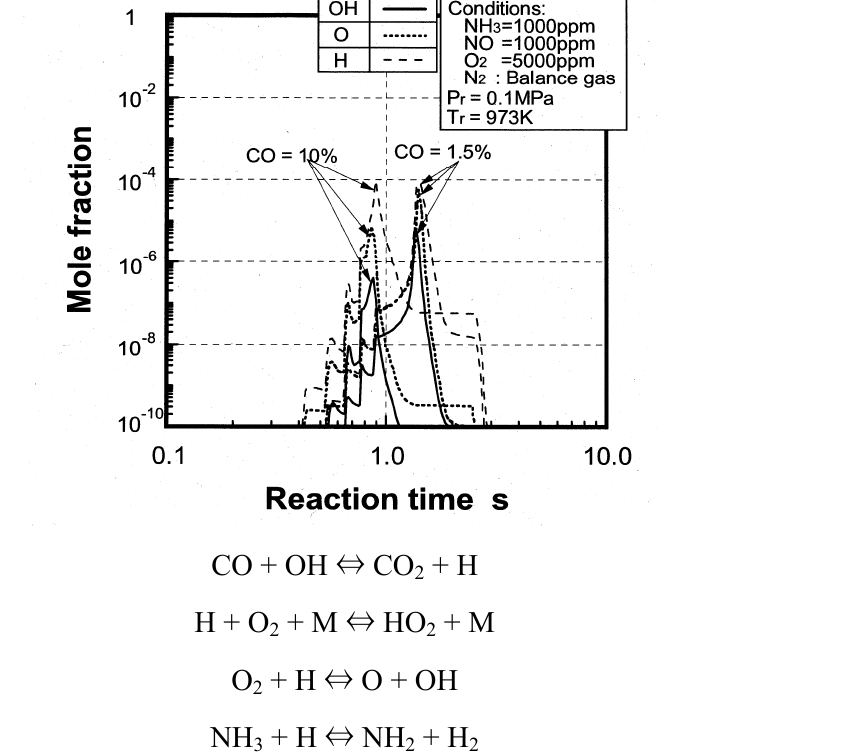
Figure 36. Mole fraction-time profiles of OH, O, H radicals, comparing CO = 0%, 1.5% -NO-O system as defined by calculation. Reaction temperature and 10%, added in the NH 3 2 is 973